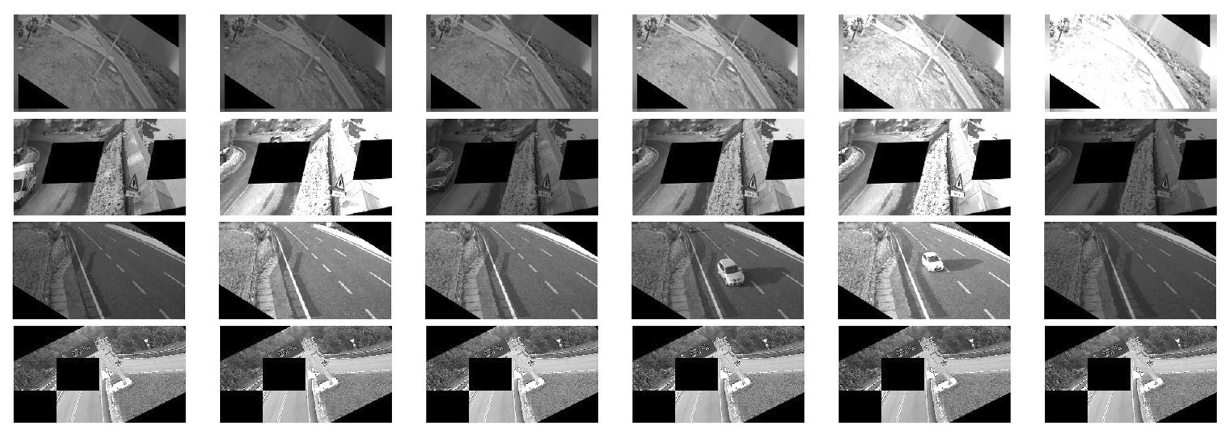
Figure 4. Examples of artificial sequences generated by combining temporally coherent spatial augmentation and simulated outdoor illumination